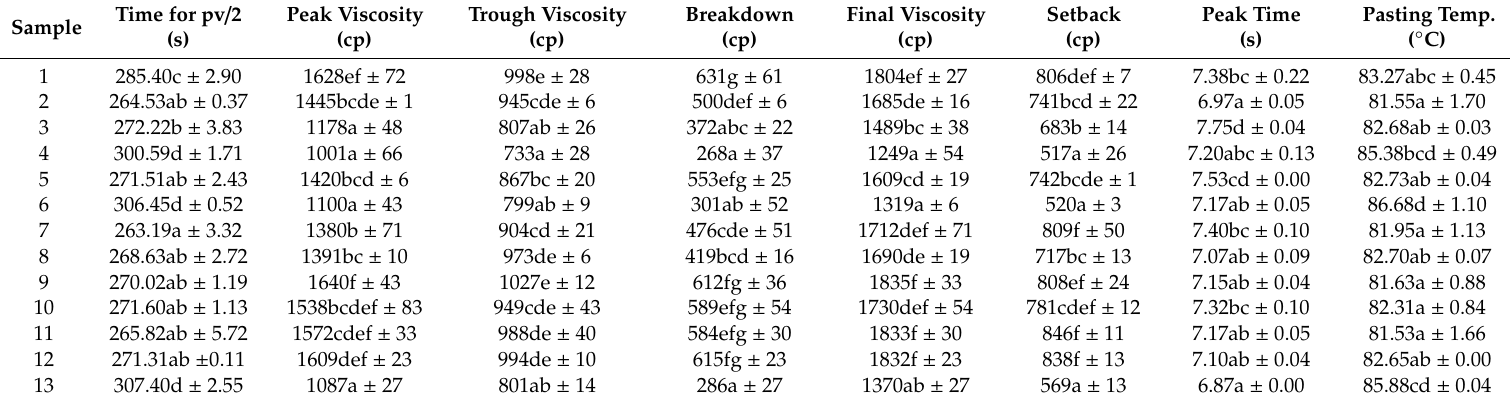
Table 3. RVA parameters of 13 bean flours obtained using distilled water with a pressurized system reaching 130 ◦ C.